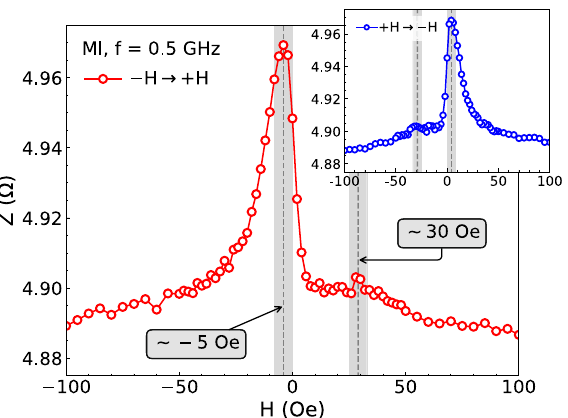
Figure 1. The MI curve for increasing field at the frequency of 0.5 GHz for our NiFe/Cu/Co film with t 10 nm. The gray zones indicate the position in field of the MI peaks. Specifically, for this film with Cu = t 10 nm, they are found at 5 and 30 Oe. The MI curve taken when the field goes from positive to Cu = ∼ − ∼ negative values is shown in the inset. In this case, the reverted asymmetric behavior is verified; and the gray 5 and 30 zones locate the position in field of the MI peaks as well, here at ∼ ∼ −